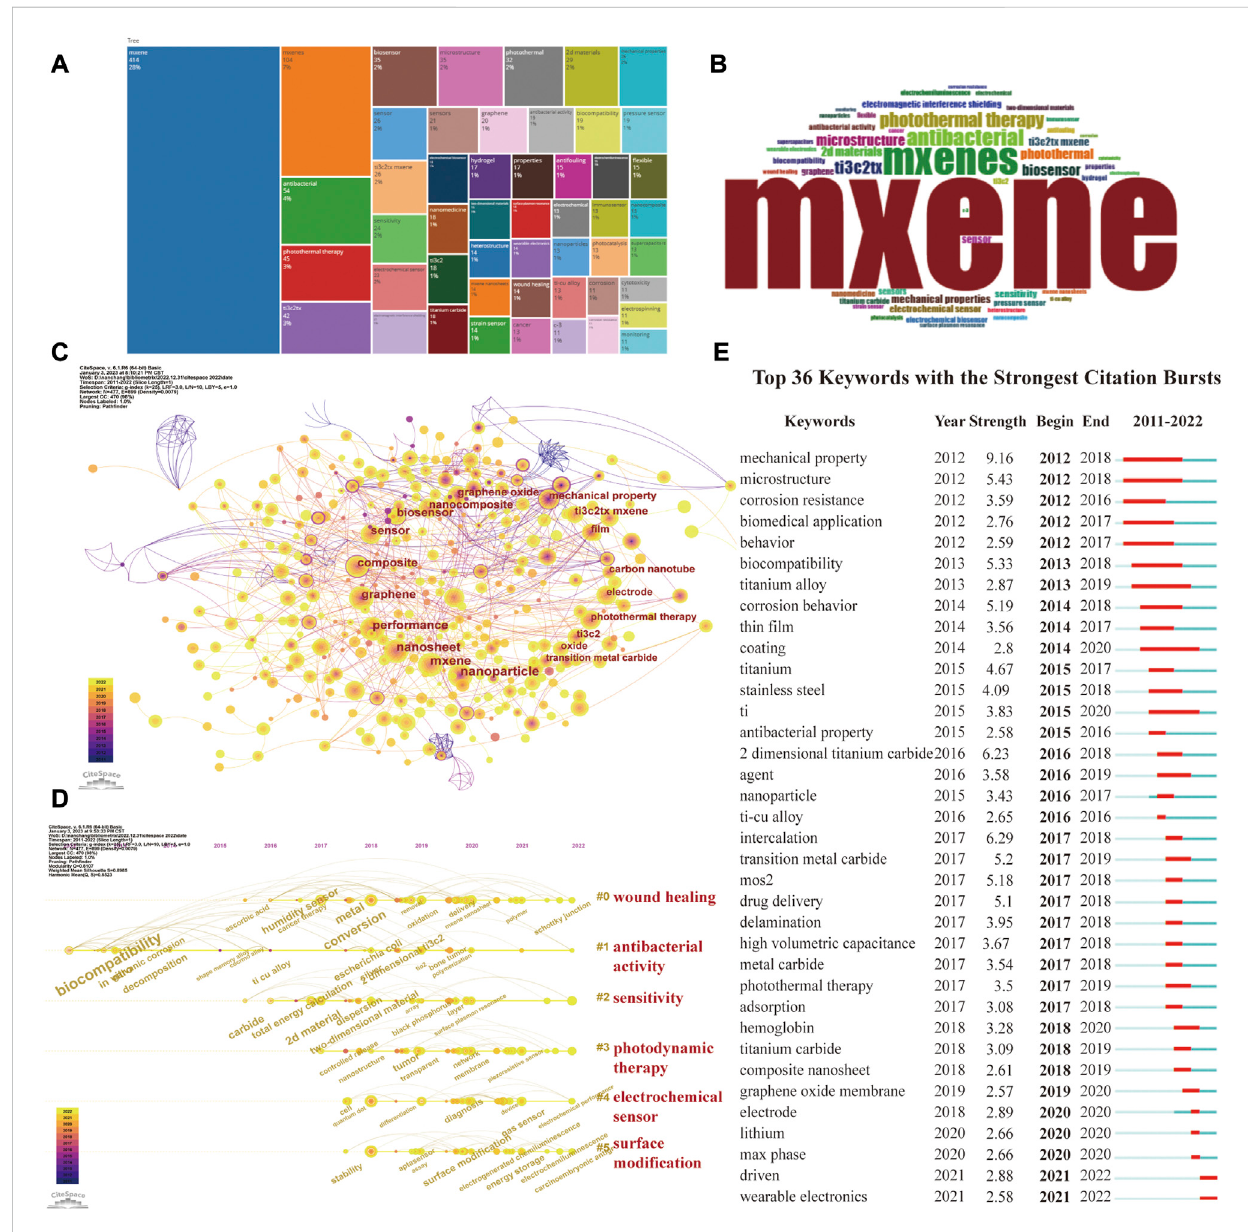
FIGURE 6 Visual image of keyword analysis. (A) The frequency of active keywords. (B) World cloud of key word. (C) Keywords of MXene for biological applicationandtheirinteraction. (D) Timelinedistributionofclusteranalysisofkeyword. (E) Representativeburstkeywordsamongtop28referenceswith the strongest citation